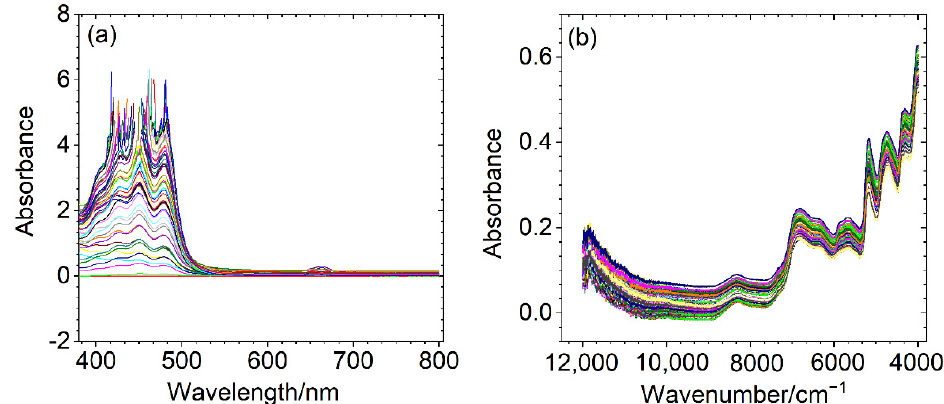
Figure 1. Measured spectra for adulterated vegetable oil ( a ) and herb ( b ) datasets.